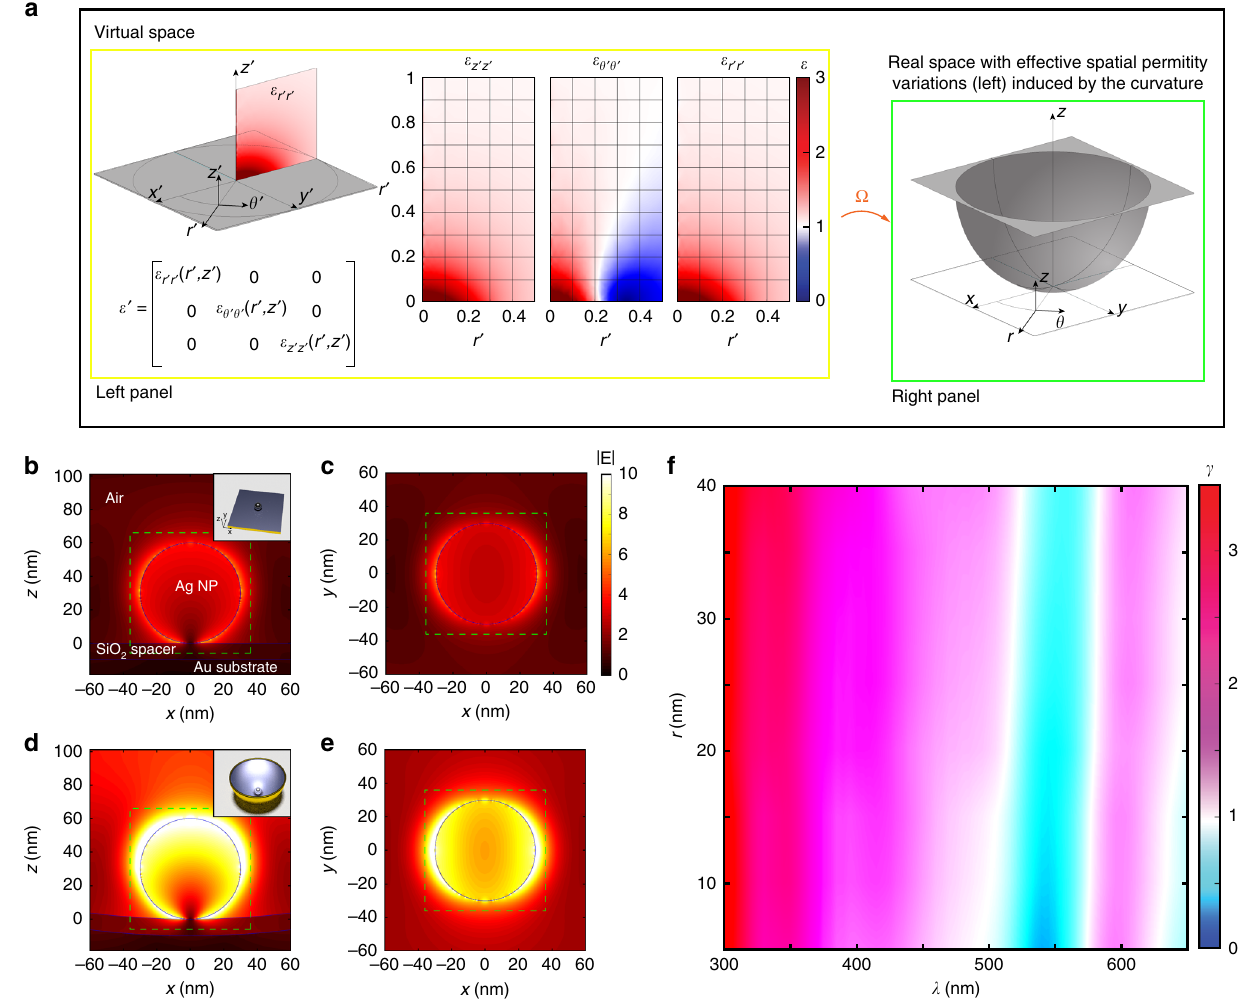
Fig. 1 Curvature-induced broadband fi eld enhancement. a Left panel: A desired but unrealistic distribution of refractive index of air above a fl at substrate that can achieve light con fi nement. The permittivity ε ′ is presented in cylindrical coordinates ( r ′ , θ ′ , z ′ ). Right panel: Transformed structure obtained by applying a coordinate mapping ( x , y , z ) = Ω ( x ′ , y ′ , z ′ ), with permittivity above the substrate equal to 1. The spatial variation of ε ′ in left panel is mapped to the spatial curvature without changing the dynamics of the electromagnetic waves. b , c 3D FDTD simulations for a Ag nanoparticle on fl at Au substrate with 10 nm thick silica spacer in between. The inset in b is a schematic of the setup. d , e 3D FDTD simulations for a Ag nanoparticle on warped Au substrate. The inset in d is a schematic of the setup. A prominent fi eld enhancement is demonstrated due to the effective gradient of permittivity described = j E j in a . f A summary of the averaged fi eld enhancement factor γ ¼ j E j for different wavelength λ and particle radius r . A broadband enhancement is curv flat illustrated for all nanoparticles with different sizes, owing to the wavelength independence permittivity gradient induced by